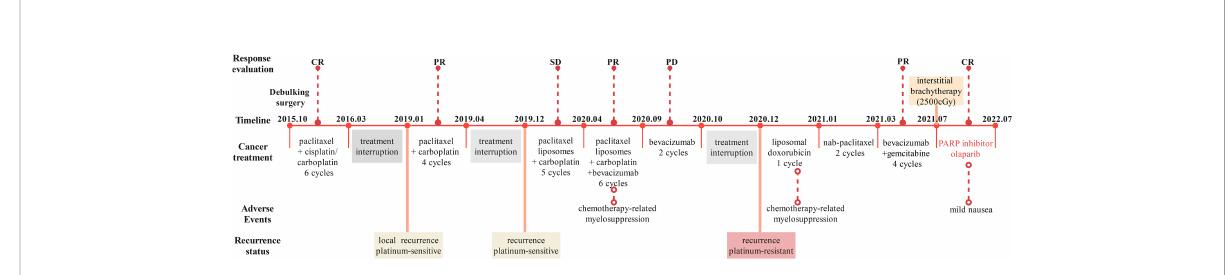
FIGURE 1 Complete timeline for treatment regimens, disease status and patient treatment